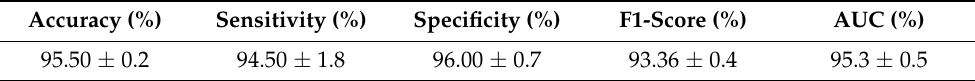
Table 5. Aggregated classification metrics across five-folds expressed as mean and standard deviation.